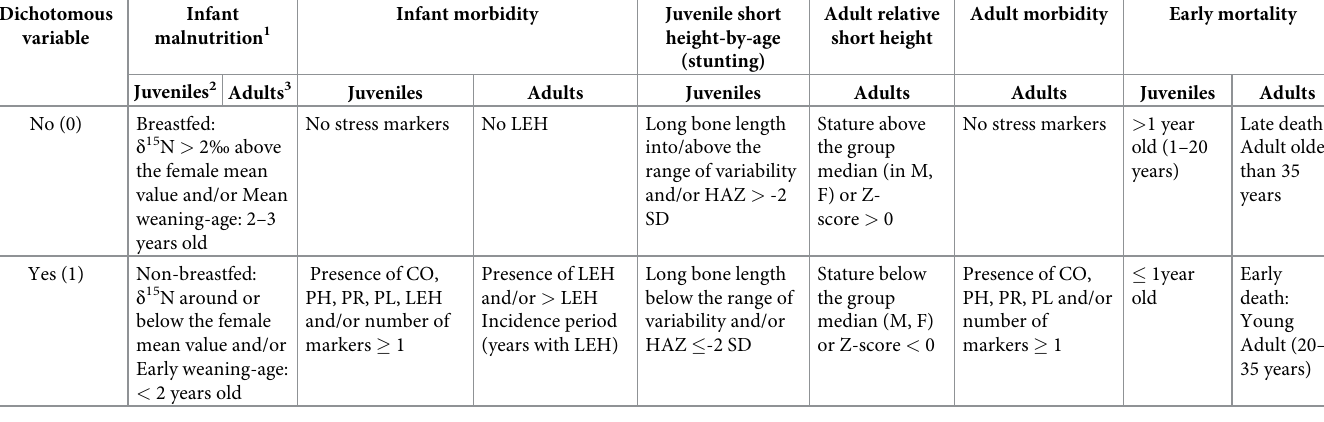
Table 1. Operationalization of stress markers in dichotomous variables for logistic regression